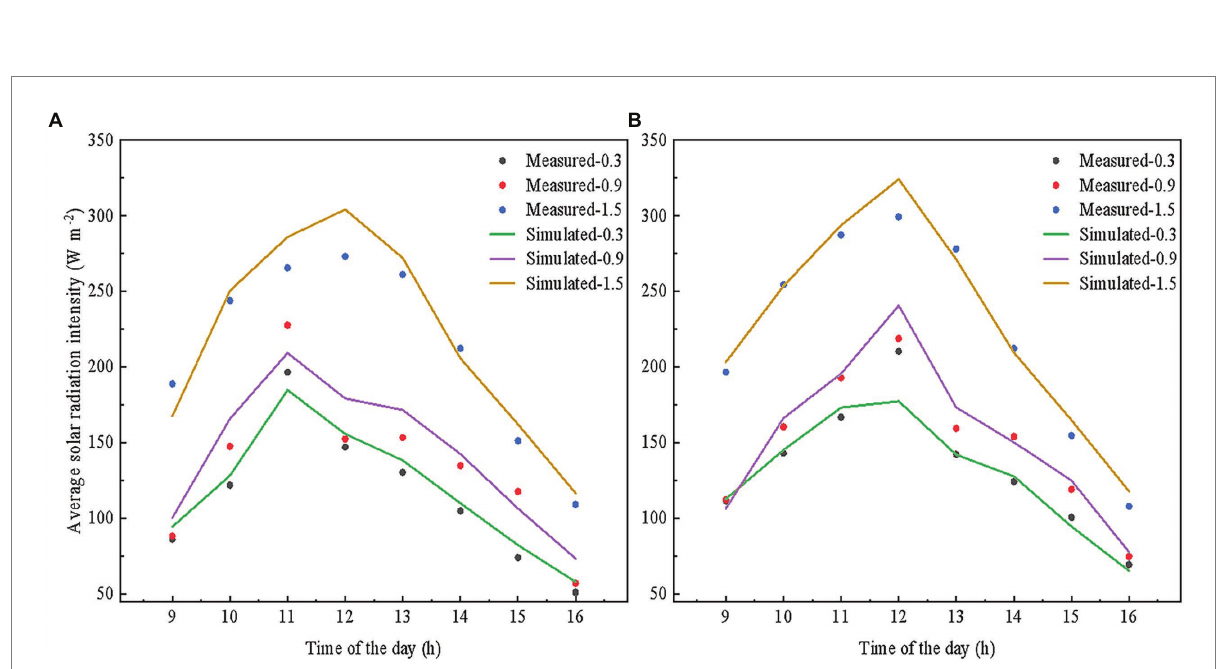
FIGURE 6 Measured versus simulated solar radiation intensities at 0.3/0.9/1.5 m heights (A) without, and (B) with reflective films on December 3rd, 2021. The measured and simulated solar radiation intensity at different positions per height were averaged, respectively, for